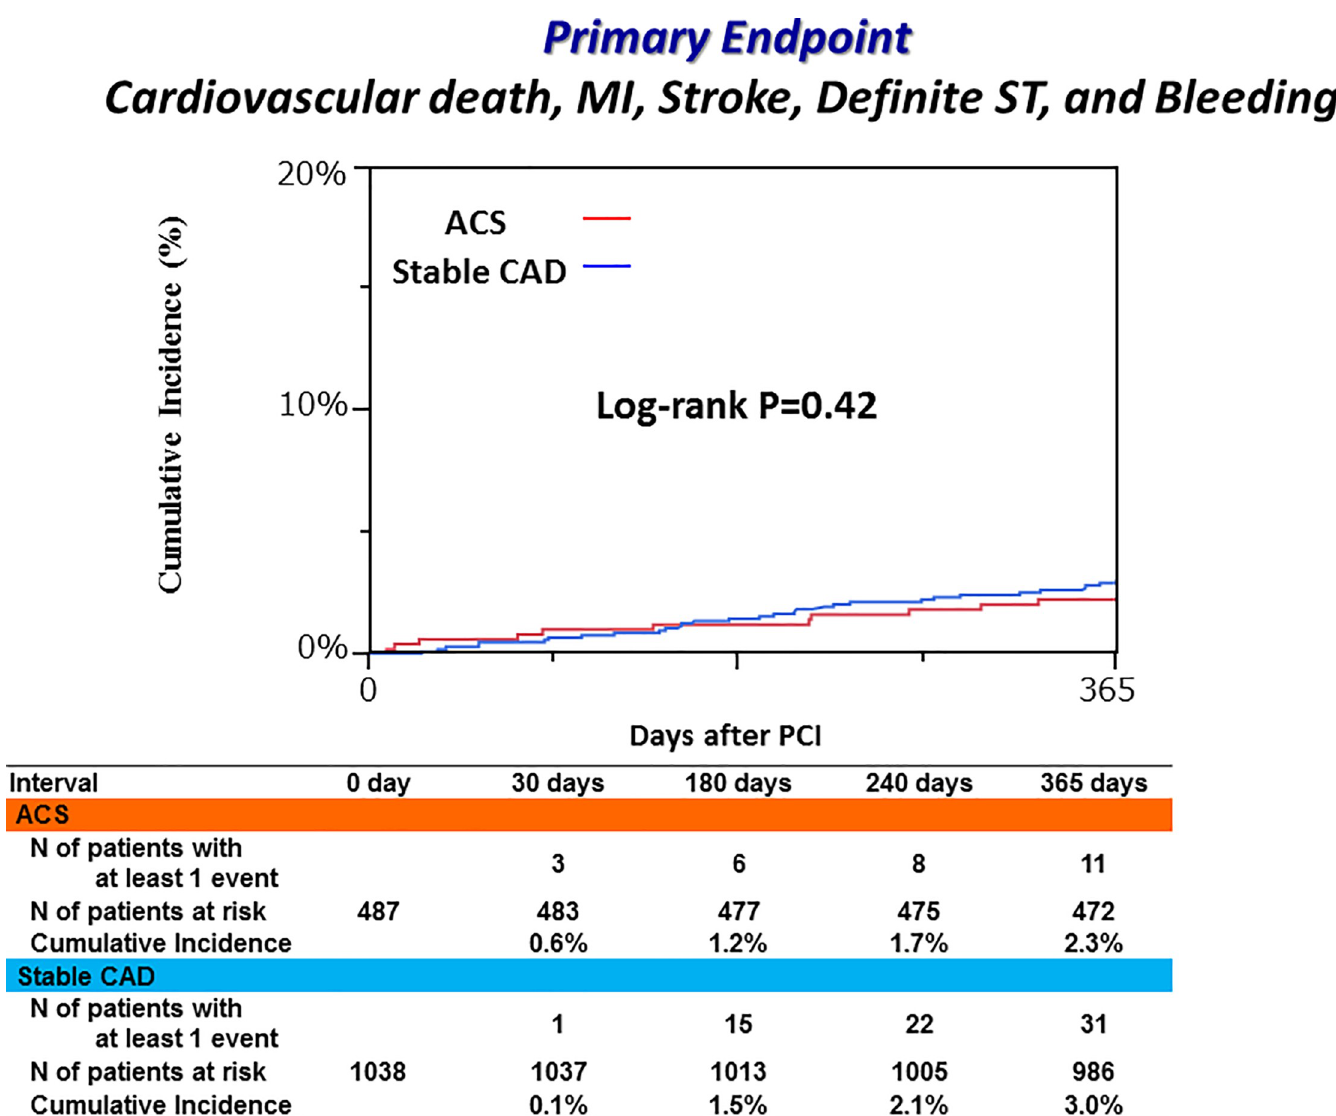
Fig 3. Cumulative incidence of the primary endpoint. Primary endpoint was defined as a composite of cardiovascular death, MI, stroke, definite ST and TIMI major/ minor bleeding. MI, myocardial infarction; ST, stent thrombosis; TIMI, Thrombolysis in Myocardial Infarction; ACS, acute coronary syndrome; CAD, coronary artery disease; PCI, percutaneous coronary